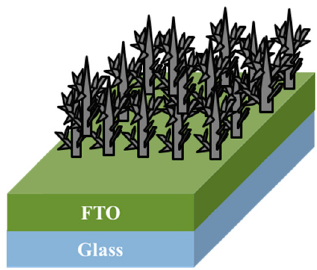
Figure 1. Schematic diagram of the TiO 2 extended gate field effect transistor (EGFET) sensor.